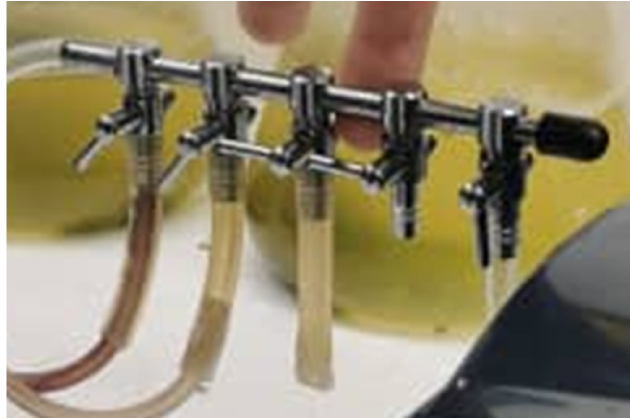
Figure 3. A 5-way air fl ow control spli tt